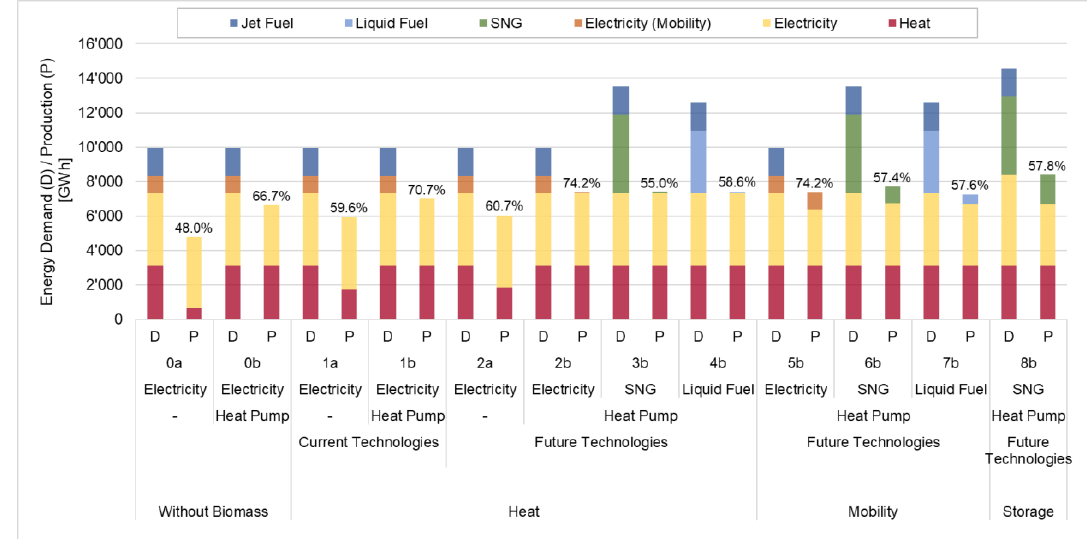
Figure 4. Overview of the scenarios 0a – 8b, separated into energy demand (D) and production (P) for various forms of energy, with a percentage of the total coverage of each scenario.